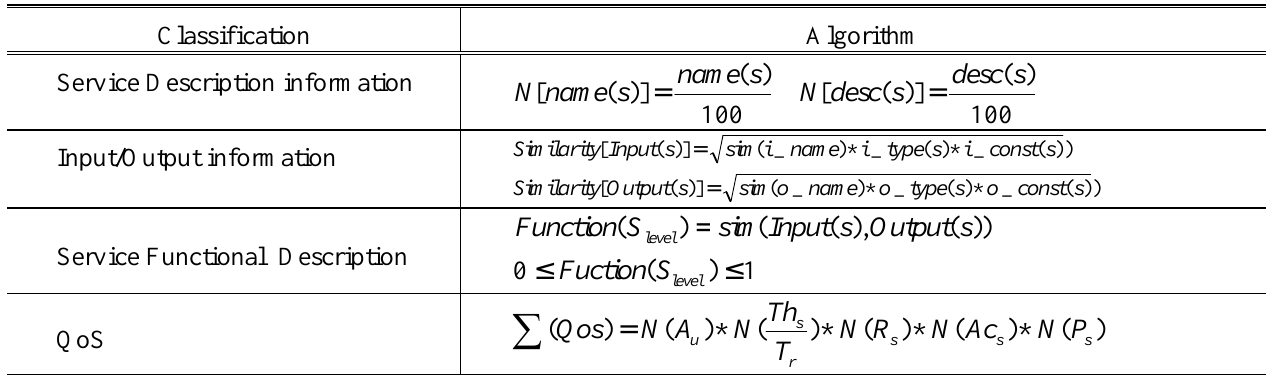
Table 3. The Algorithm of Web Services Matching Factors